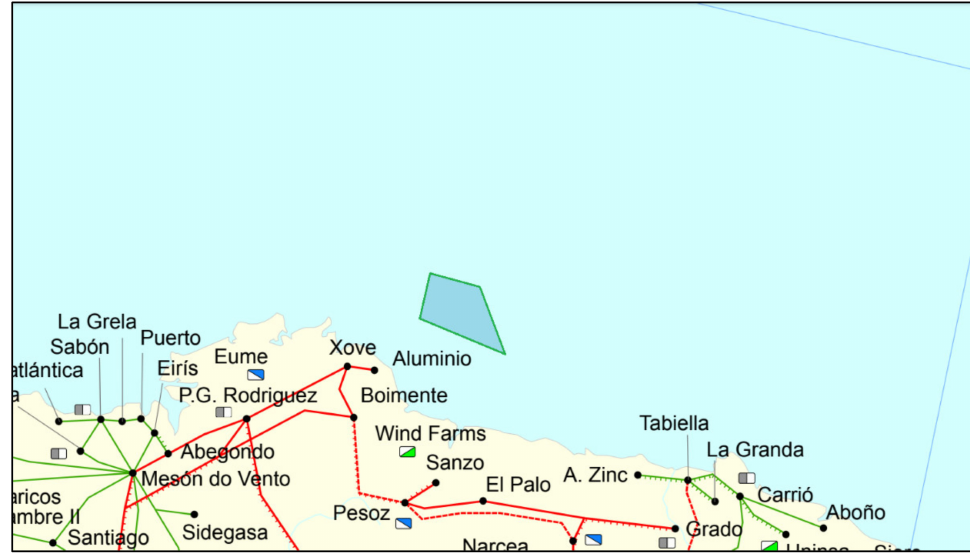
Figure 3. Spanish electricity transmission network near